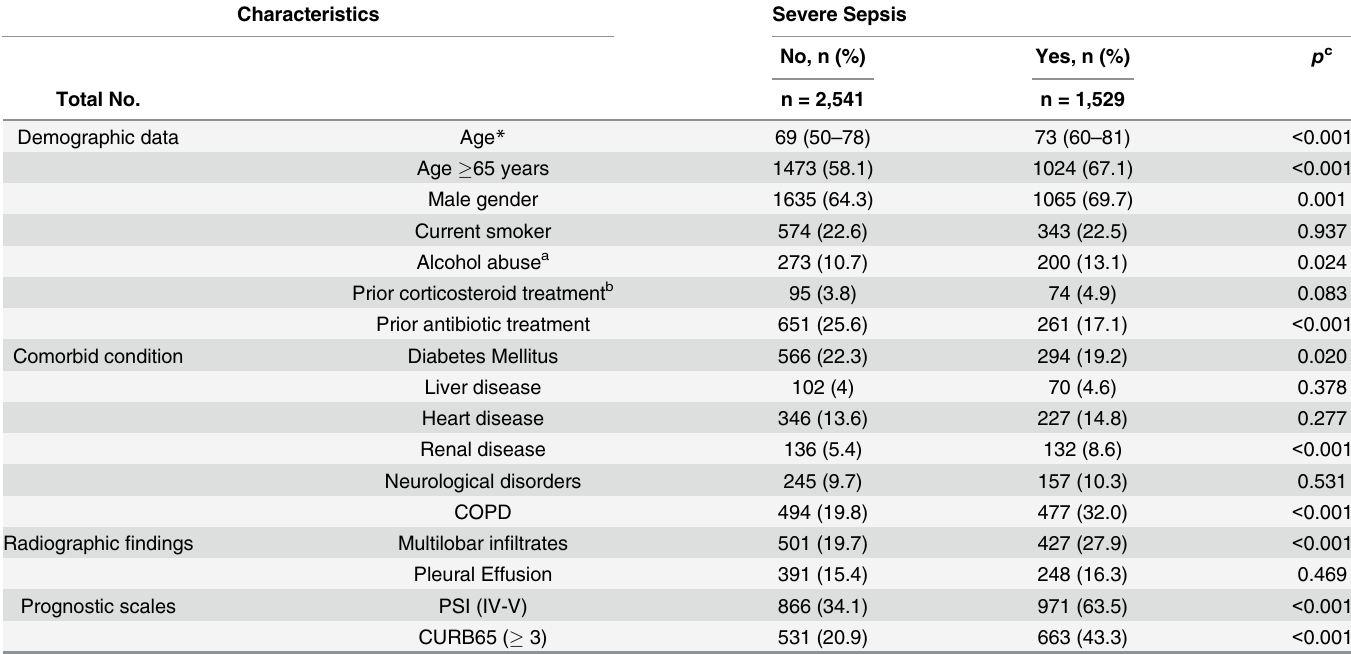
Table 1. Characteristics of CAP with severe sepsis: demographic data, comorbid conditions, radiographic and prognostic scales data. Characteristics